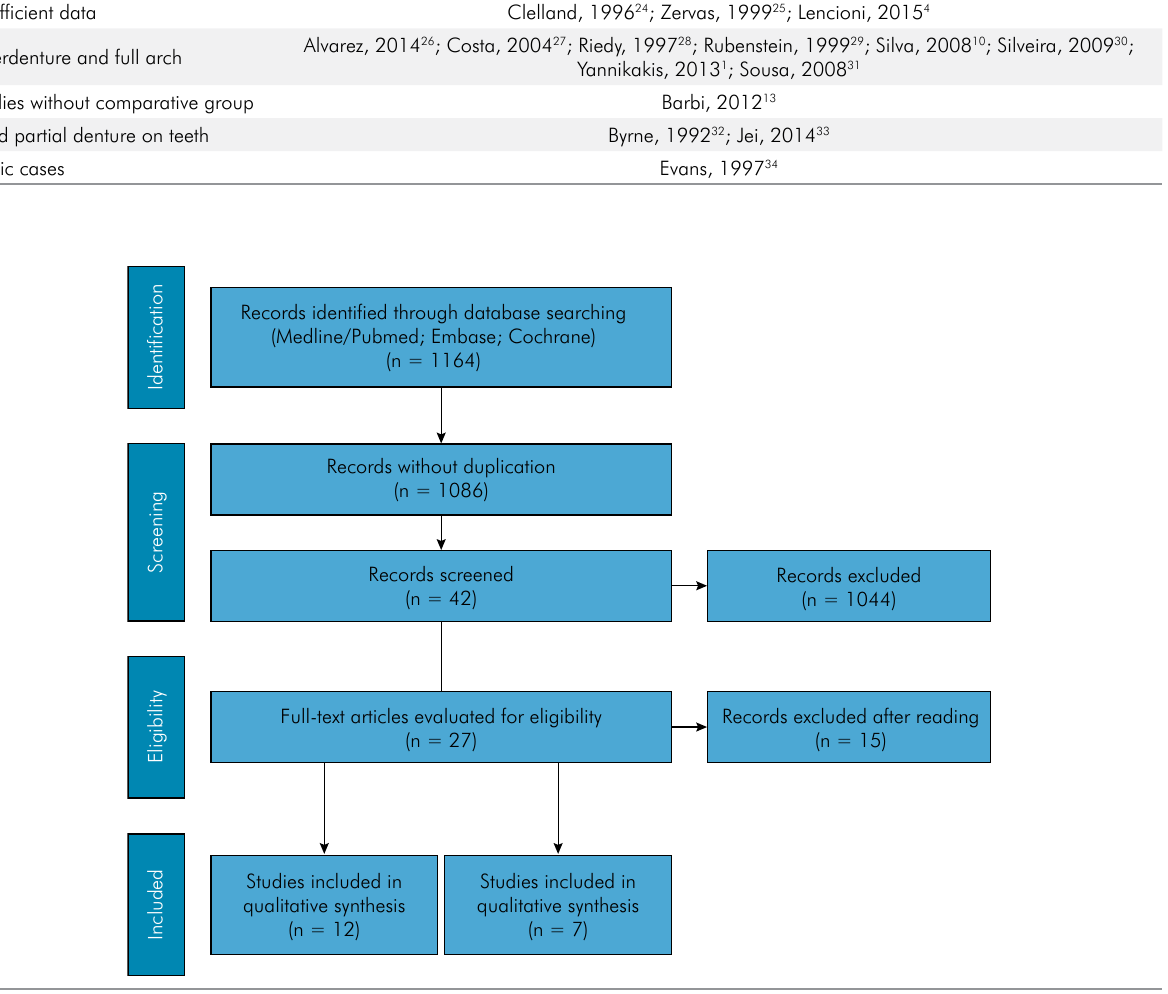
Figure 1. Flowchart detailing the search